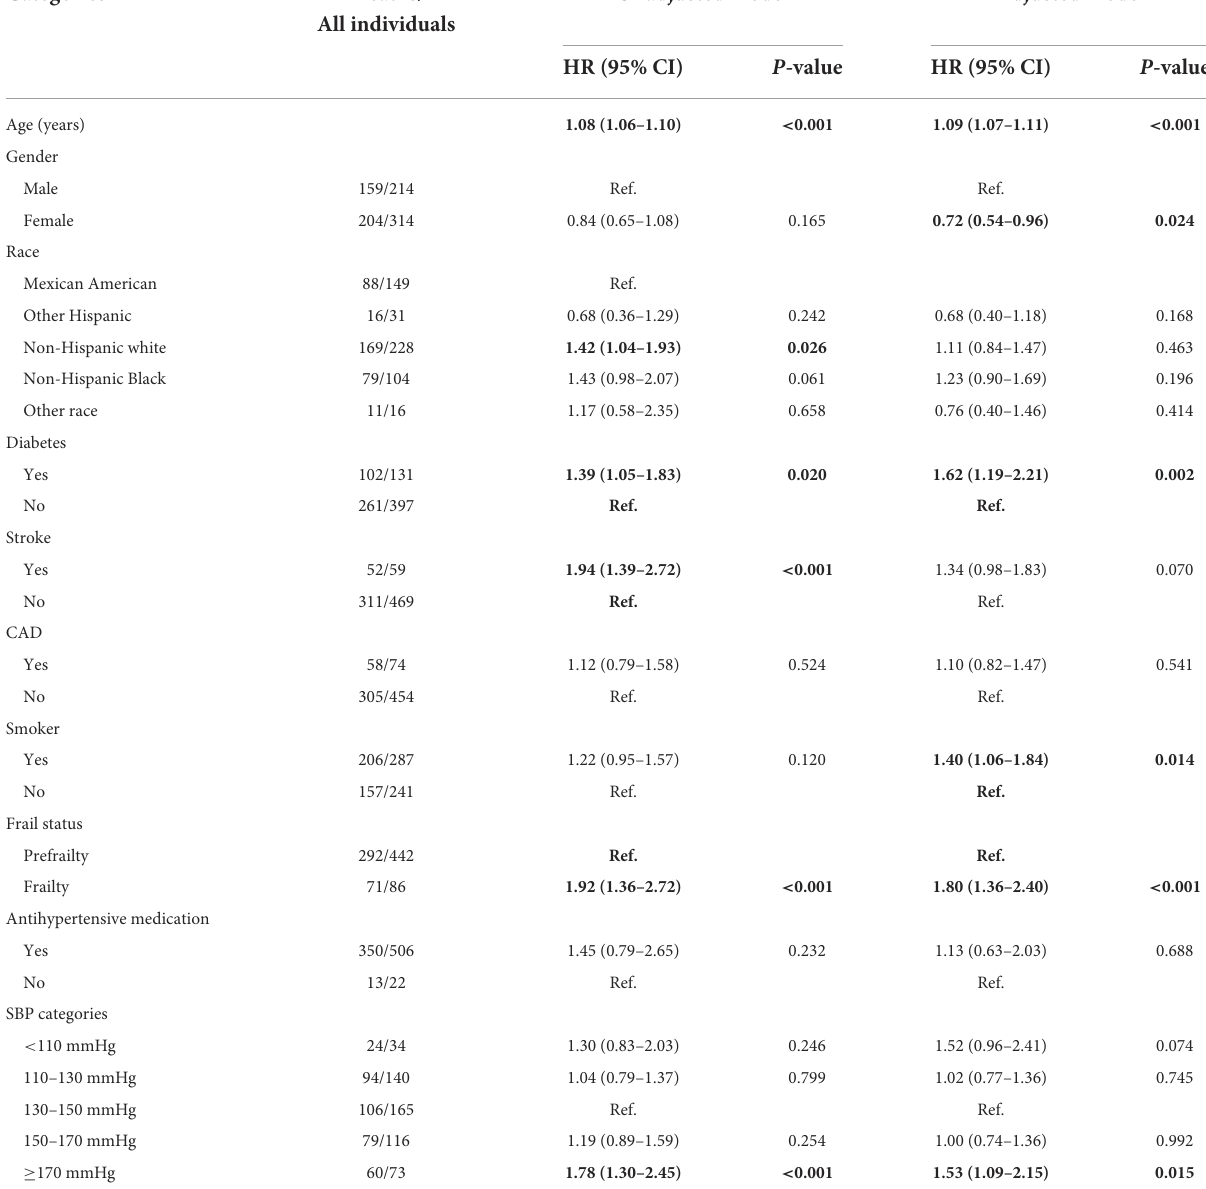
TABLE 2 Cox regression analyses of all-cause mortality for